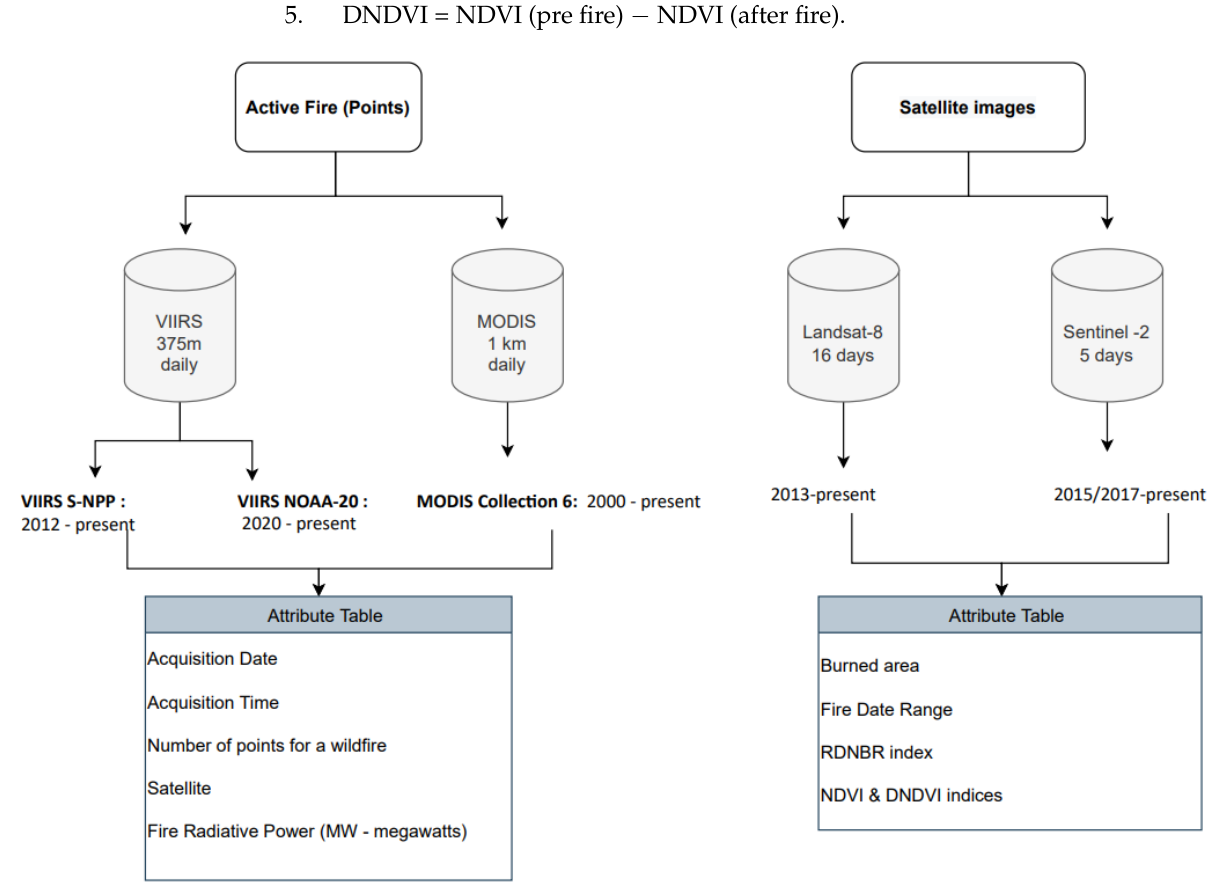
Figure 2. The remote sensing sources used for creating Israel’s national wildfire database (https://earthdata.nasa.gov/earth-observation-data/near-real-time/firms, accessed on 5 July 2021); NASA Near Real-Time and MCD14DL MODIS Active Fire Detections (SHP format). Dataset available online (https://earthdata.nasa.gov/active-fire-data, accessed on 5 July 2021). The MOD14 Collection 6 daytime global commission error is 1.2% [33]; NASA Near Real-Time VNP14IMGTDL_NRT VIIRS 375 m Active Fire Detections (SHP format). Datasets available online (https://earthdata.nasa.gov/active-fire-data, accessed on 5 July 2021).